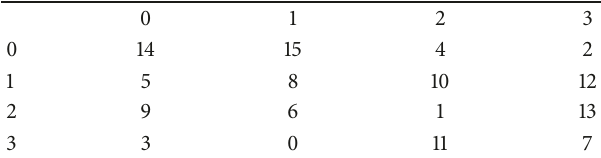
Table 8: The proposed 4 × 4